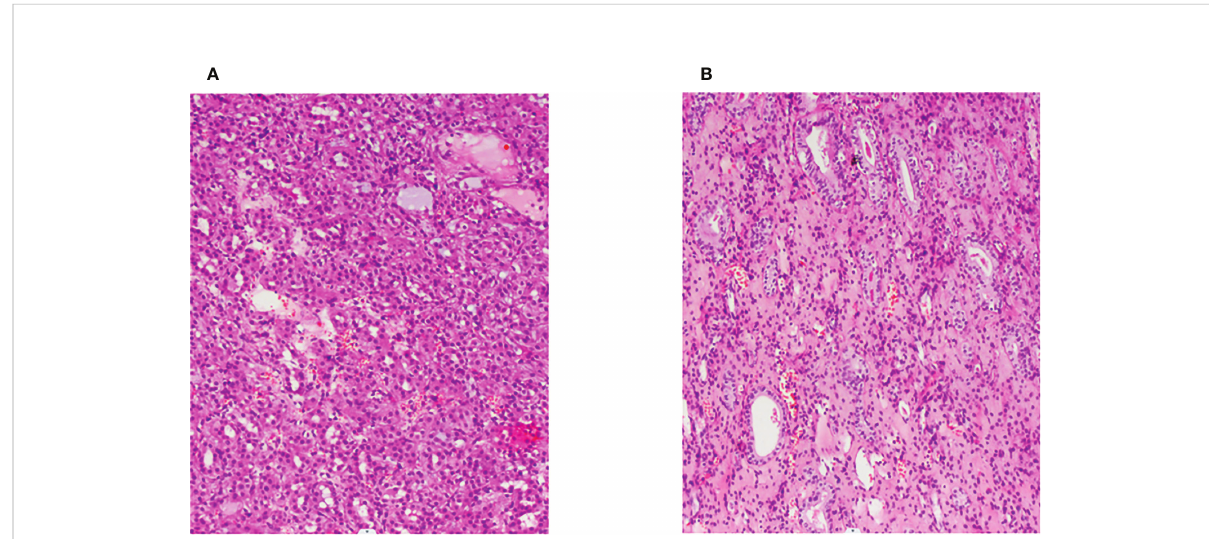
FIGURE 2 Pathological section (H&E, ×100). (A, B) : Hematoxylin – eosin staining showed that the cytoplasm of renal cell carcinoma was eosinophilic and had a tubular and glandular